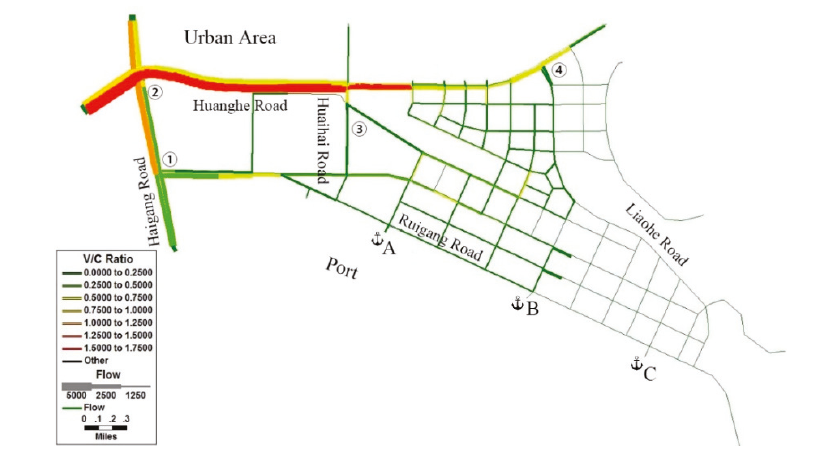
Figure 19: The traffic volume of PCDN in 2030 without interchange.